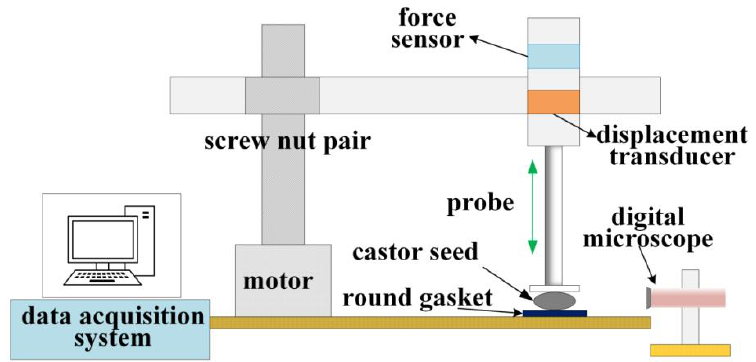
Figure 1. Schematic diagram of principle of in situ observation composite texture